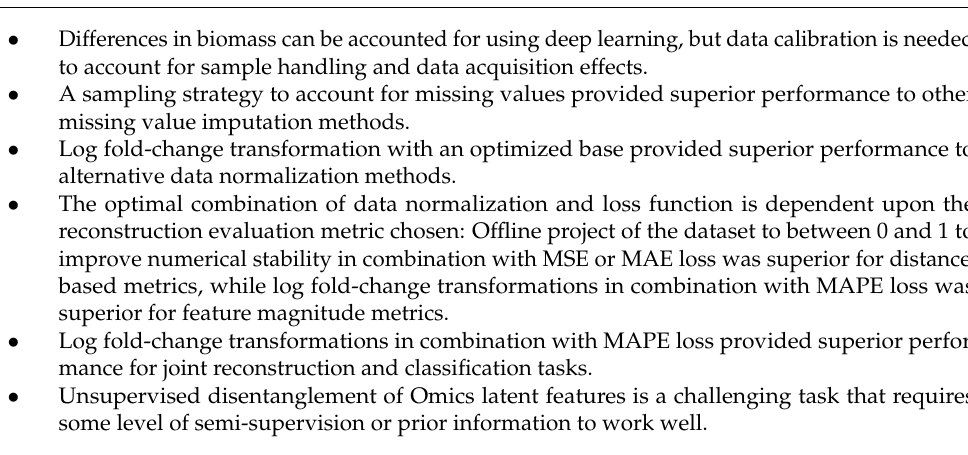
Table S2: Classification results for Dataset 2 using a feedforward MLP with a hidden layer size of 8 units as described in the Methods section, Table S3: Classification results for Dataset 2 using a feedforward MLP with a hidden layer size of 2 units, Table S4: Reconstruction results for Dataset 1 using a VAE architecture as described in the Methods section, Table S5: Reconstruction results for Dataset 2 using a VAE architecture as described in the Methods section, Table S6: Supervised latent space disentanglement of class and style attribute reconstruction and classification results for Dataset 1 using the JointVAE architecture as described in the Methods section, Table S7: Supervised latent space disentanglement of class and style attribute reconstruction and classification results for Dataset 2 using the JointVAE architecture as described in the Methods section, Table S8: Semi-supervised latent space disentanglement of class and style attribute reconstruction and classification results for Datasets 1 and 2 using the JointVAE architecture as described in the Methods section. Table S9: Unsupervised latent space disentanglement of class and style attribute reconstruction results for Datasets 1 and 2 using the JointVAE architecture as described in the Methods section, Table S10: Latent space classification results for Dataset 1 using the JointVAE architecture as described in the Methods section, Table S11: Latent space classification results for Dataset 2 using the JointVAE architecture as described in the Methods section, Table S12: Latent space traversal results for Dataset 1 using the JointVAE architecture and evaluation procedure as described in the Methods section, Table S13: Latent space traversal results for Dataset 2 using the JointVAE architecture and evaluation procedure as described in the Methods